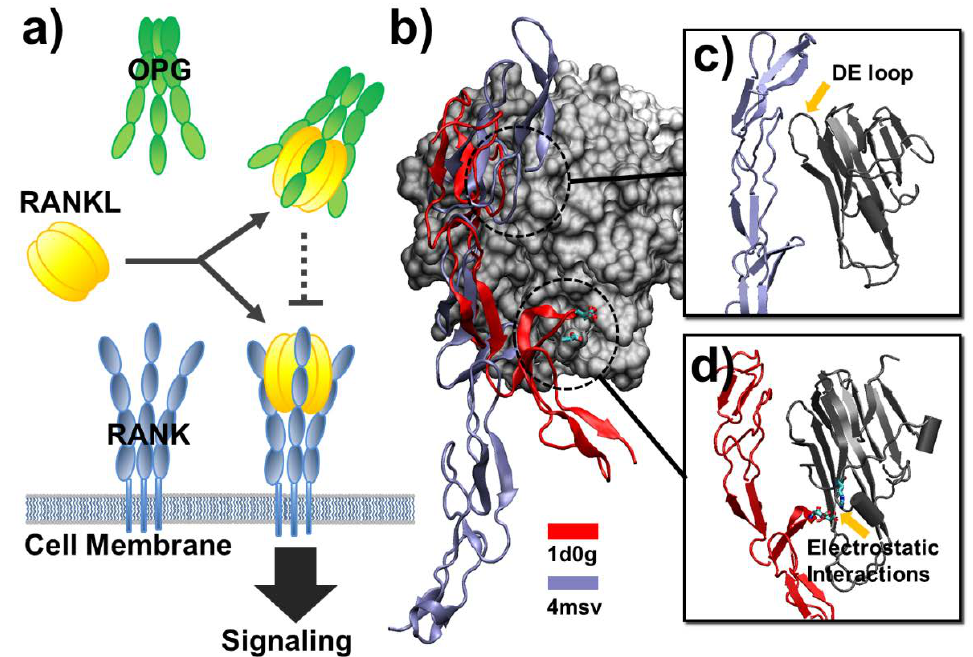
Figure 6. We provide insights to the biological functions of di ff erent ligand–receptor interactions.